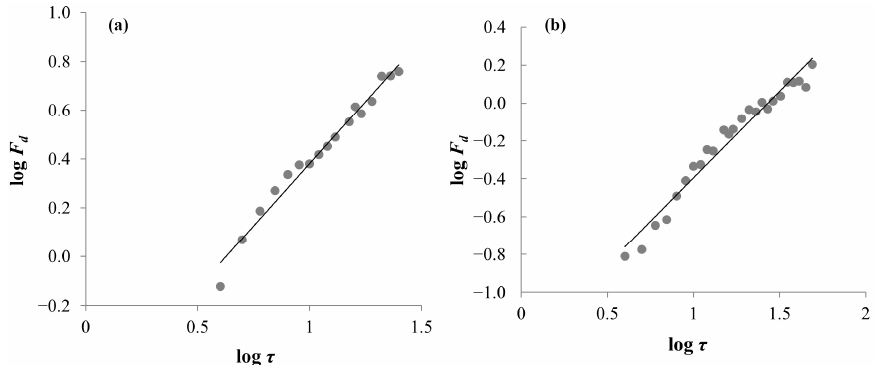
Figure 10. Graph log–log plot of the square root mean fluctuation function, F d , for the detrended and deseasonalized timeseries of ( a ) WTD vs. time interval τ (25-year step, with the corresponding linear fit y = 1.02x − 0.64, R 2 = 0.98) and ( b ) temperature vs. time interval τ (50-year step, with the corresponding linear fit y = 0.92x − 1.31, R 2 = 0.96).